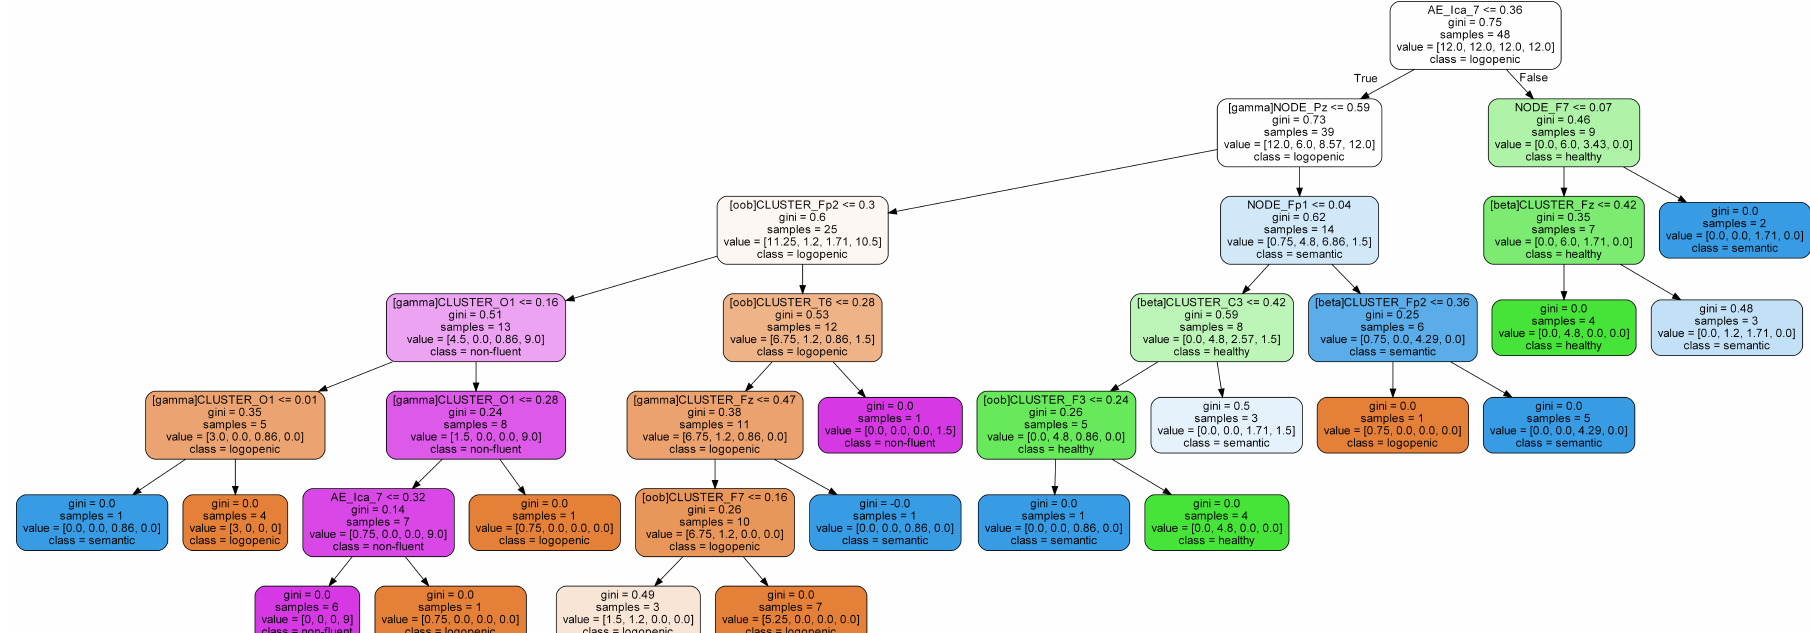
Figure 10. Representation of decisions in Decision Tree multiclass